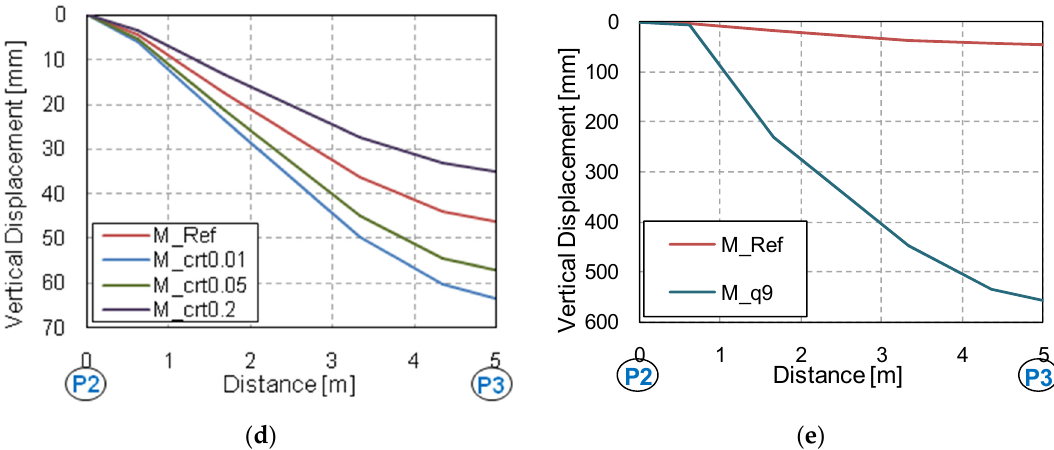
Figure 7. Numerical residual deformed shapes along 1st floor corner-bay slab between P2 and P3 obtained by varying ( a ) concrete tensile strength, ( b ) flexural reinforcement ratio, ( c ) number of floors, ( d ) column removal time and ( e ) superimposed load. Positive values indicate downward displacements. Table 4. Vertical displacement peak and residual values obtained at five points on the 1st floor slab from P2 edge to P3 edge. Units in mm. Model